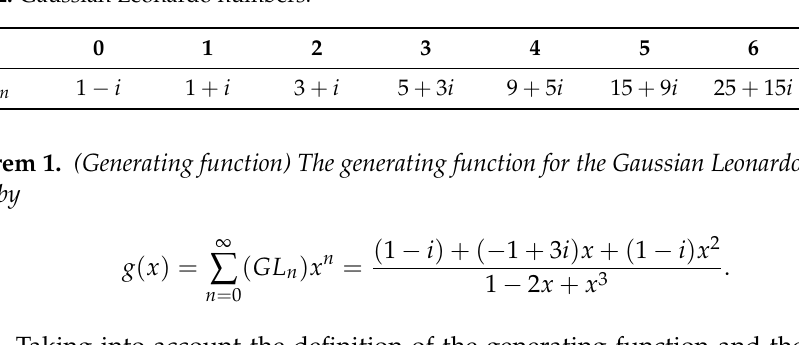
Table 2. Gaussian Leonardo